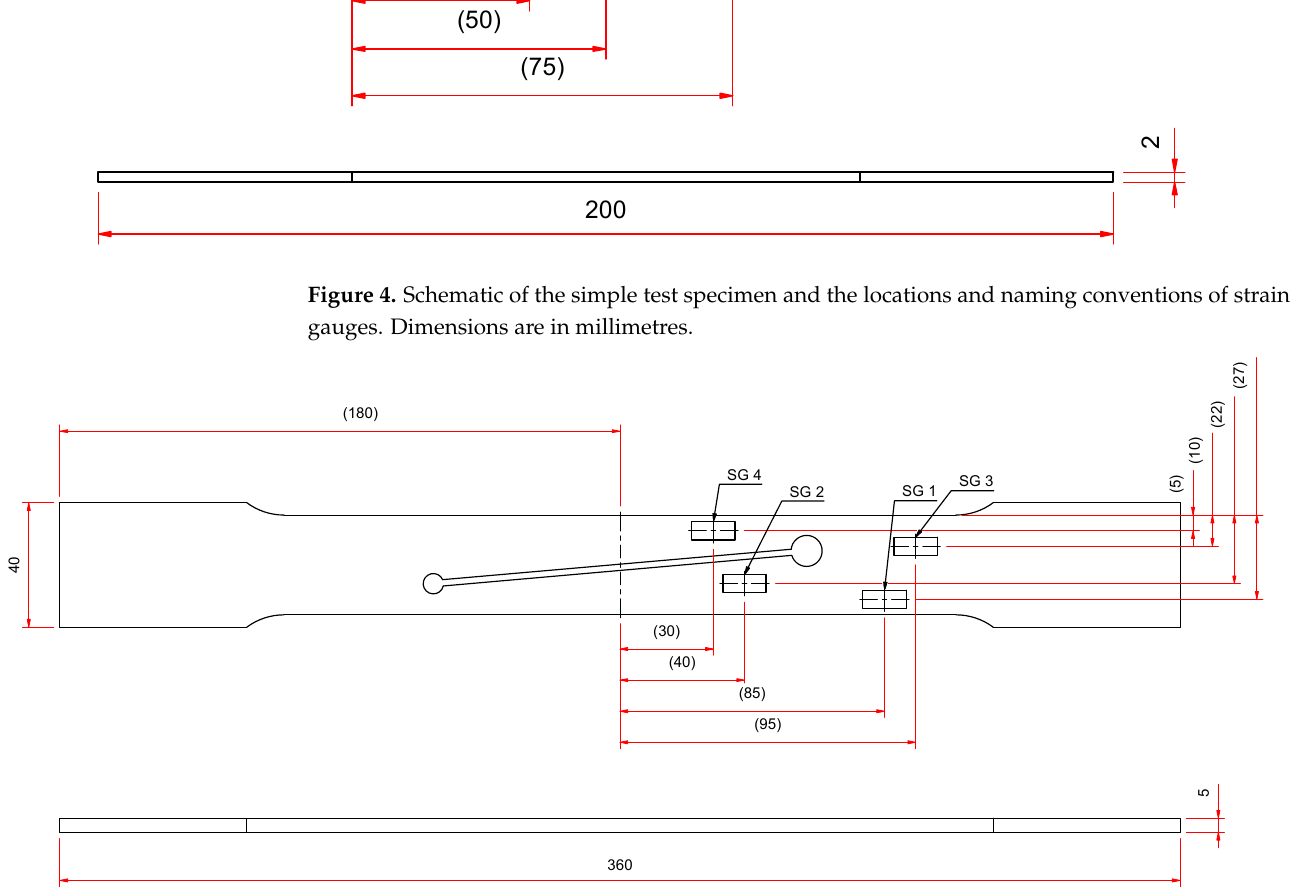
Figure 5. Schematic of the complex test specimen and the locations and naming conventions of strain gauges. Dimensions are in